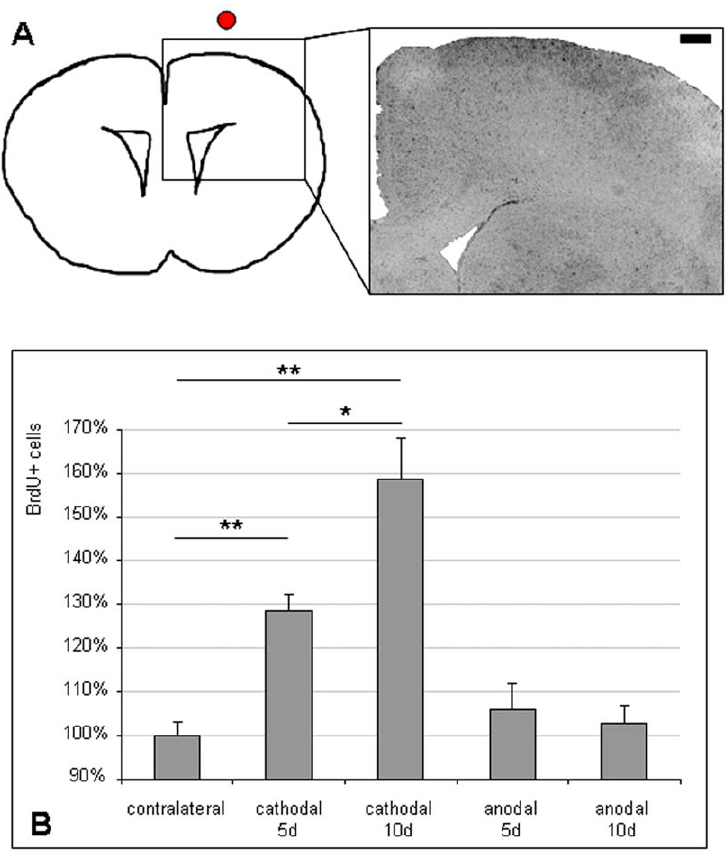
Figure 4. Cathodal tDCS increases the number of proliferating cells in the cortex. (A) After multi-session cathodal tDCS, the number of proliferating cells identified by BrdU-incorporation was increased in the ipsilateral hemisphere (scale bar =0.5 mm). (B) This effect was only observed with cathodal stimulation. Anodal tDCS had no effect on proliferation in the cortex (means 6 SEM; **p , 0.01, *p , 0.05).